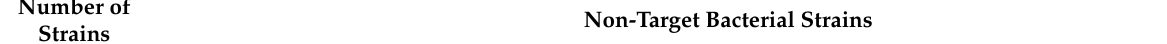
Table 2. Non-target bacterial strains used for exclusivity of the developed mPCR assay.